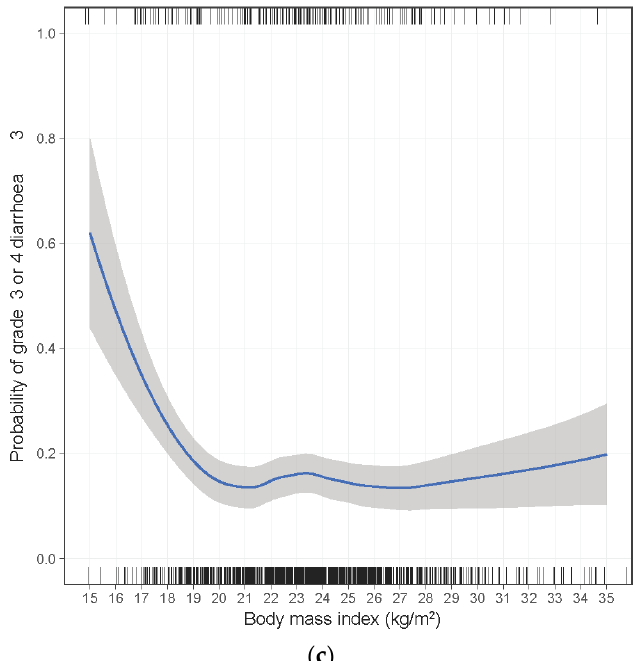
Figure 1. Loess locally weighted smoothed relationship between risk of grade ≥ 3 diarrhea and ( a ) body weight, ( b ) body surface area, and ( c ) body mass index.